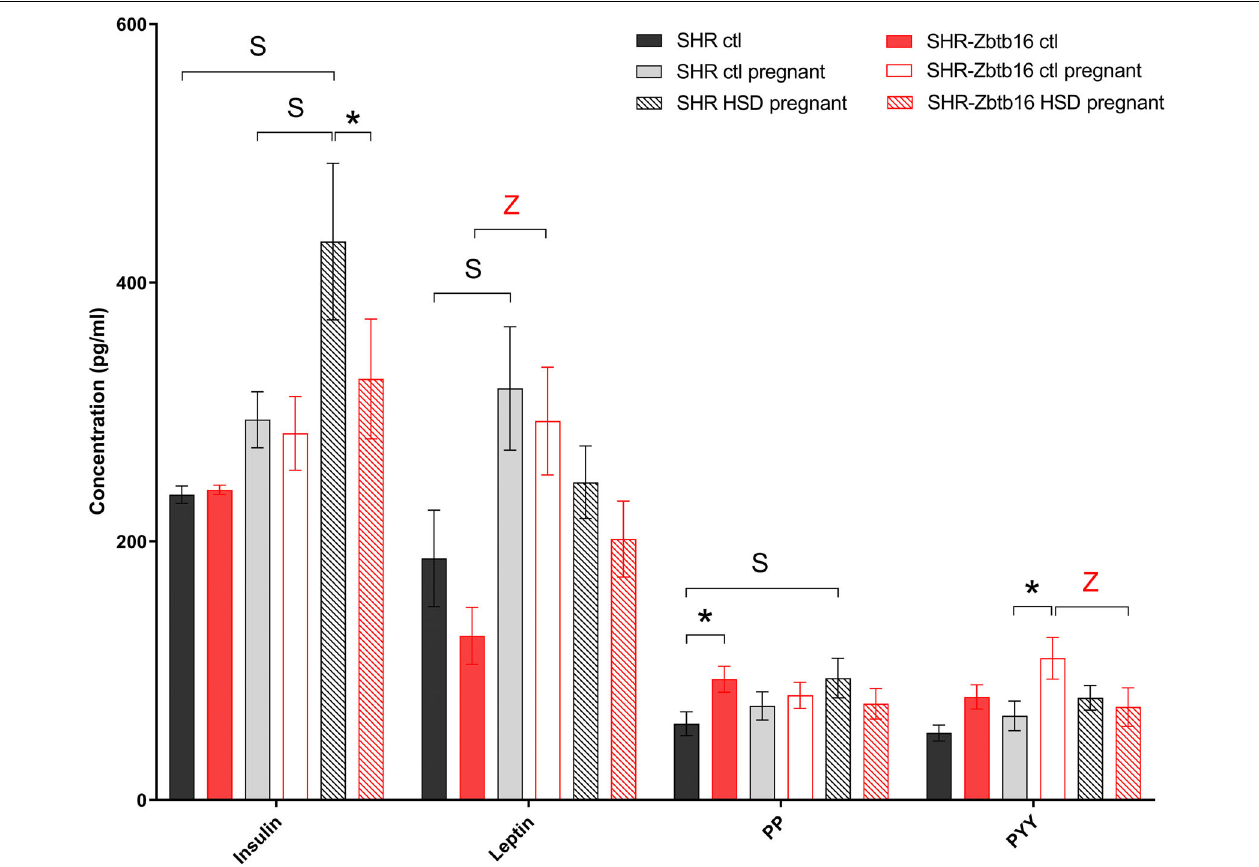
FIGURE 7 | Hormone profile. Hormone concentrations in the serum of female rats fed standard diet before pregnancy (SHR ctl: black bars, SHR- Zbtb16 ctl: red bars), standard diet in pregnancy (SHR ctl pregnant: light gray bars, SHR- Zbtb16 ctl pregnant: empty red bars), HSD in pregnancy (SHR HSD pregnant: black patterned bars, SHR- Zbtb16 HSD pregnant: red patterned bars). Within the graph, the significance levels of pair-wise group comparison (ctl vs. ctl pregnant vs. HSD pregnant) by post-hoc Fisher’s test of the two-way ANOVA with STRAIN and DIET as major factors are indicated as follows: * p < 0.05. Data are expressed as mean ± SEM. S represents differences in SHR: Leptin ∗ between SHR ctl and SHR ctl pregnant, PP ∗ between SHR ctl and SHR HSD pregnant. Z represents differences in SHR- Zbtb16 : Leptin ∗∗ betweenSHR- Zbtb16 ctl and SHR- Zbtb16 ctl pregnant, PYY ∗ between SHR- Zbtb16 ctl pregnant and SHR- Zbtb16 HSD pregnant.